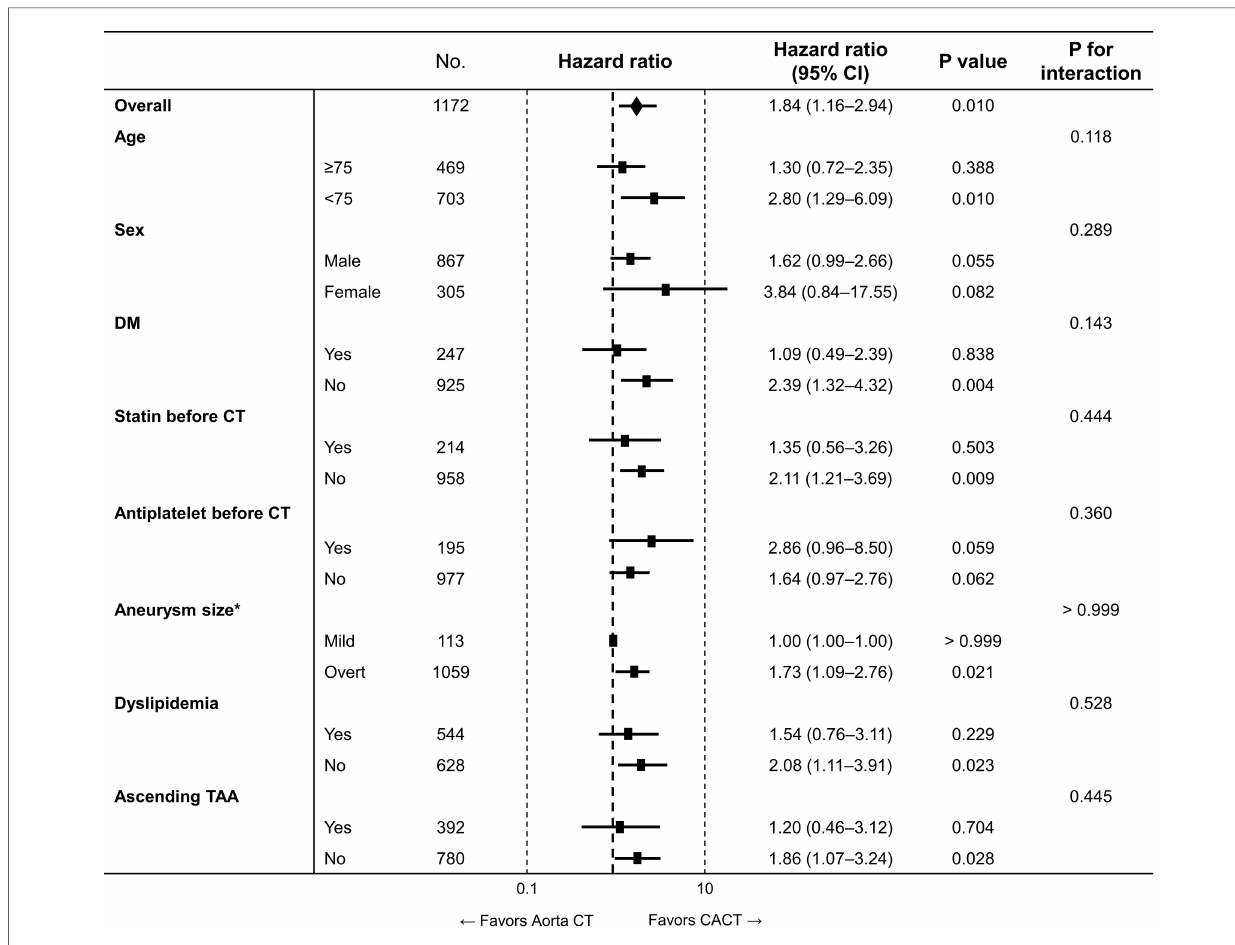
FIGURE 4 Subgroup analysis for the primary outcome. Aorta CT, thoracoabdominal aorta CT angiography protocol; CACT, coronary-aorta CT protocol; CI, con fi dence interval; CT, computed tomography; No., number; TAA, thoracoabdominal aortic aneurysm. * Mild form of aneurysm was de fi ned as abdominal aorta with a size between ≥ 20 and <30 mm or aortic arch or descending thoracic aorta with a size between ≥ 30 and <35 mm, while overt aneurysm was de fi ned as ascending aorta with a size ≥ 40 mm, aortic arch or descending aorta with a size ≥ 35 mm, and abdominal aorta with a size ≥ 30